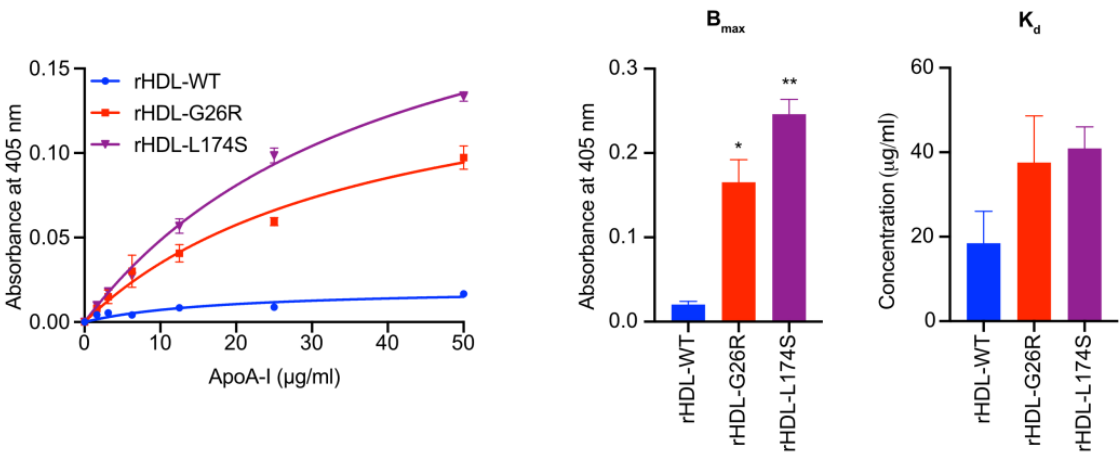
Figure 5. Lipidation decreases the binding of ApoA-I proteins to heparin. 96-well plates were coated with heparin at 25 ug/mL and probed with the rHDL containing the indicated ApoA-I amyloidogenic variants at increasing concentrations. The rHDL ability to bind heparin was quantified as a function of protein concentration (left panel). Experimental data were fitted according to the Michaelis-Menten equation and B max (middle panel) and K d (right panel) were calculated. Data shown are the means ± SEM of two independent experiments carried out in duplicate. Significance is calculated according to one-way ANOVA (* p < 0.05, ** p < 0.005).